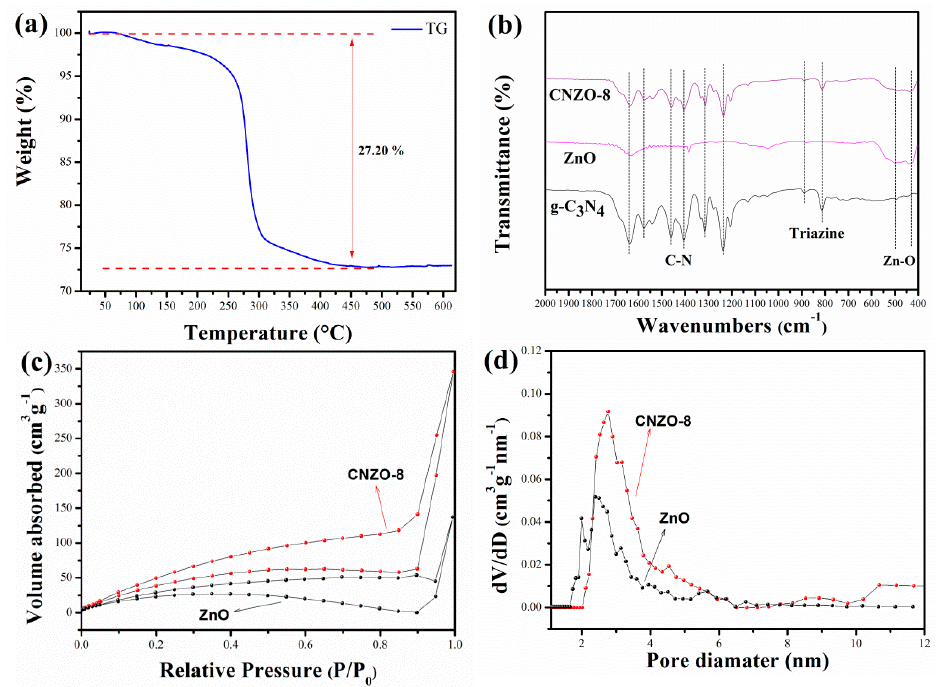
Figure 4. TG-DTA curves of the Zn 5( CO 3 ) 2 (OH) 6 precursor ( a ) and FT-IR spectra ( b ) of g-C 3 N 4 , ZnO, CNZO-3, CNZO-5 and CNZO-8, Nitrogen adsorption / desorption isotherms ( c ) and pore size distribution ( d ) of ZnO and CNZO-8.